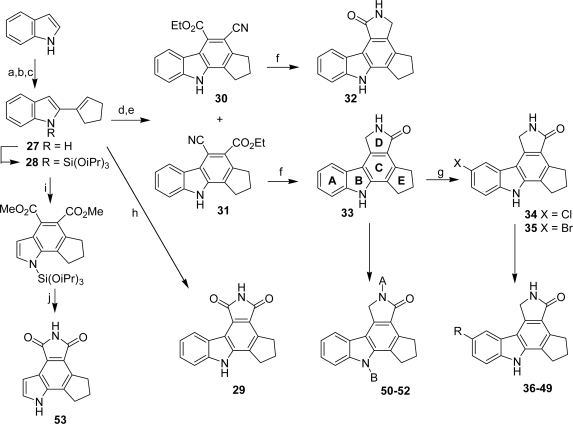
(a) n-BuLi, THF, −78 °C to 20 °C, then CO2(g). (b) t-BuLi, THF, −78 °C to 20 °C, then cyclopentanone. (c) 2M HCl, acetone, rt. (d) cis-EtO2CCH=CHCN, PhCl, 125 °C. (e) DDQ, toluene, 60 °C. (f) H2, Ra-Ni, DMF, rt. (g) NCS or NBS, DMF, rt. (h) maleimide, tetrachloroquinone, neat, 190 °C. (i) dimethyl acetylenedicarboxylate, 150 °C, 64 h. (j) (1) 10N NaOH in EtOH, reflux, 3 h, (2) Ac2O, 73 h, (3)(TMS)2NH/MeOH, DMF, 73 °C, 4 h.